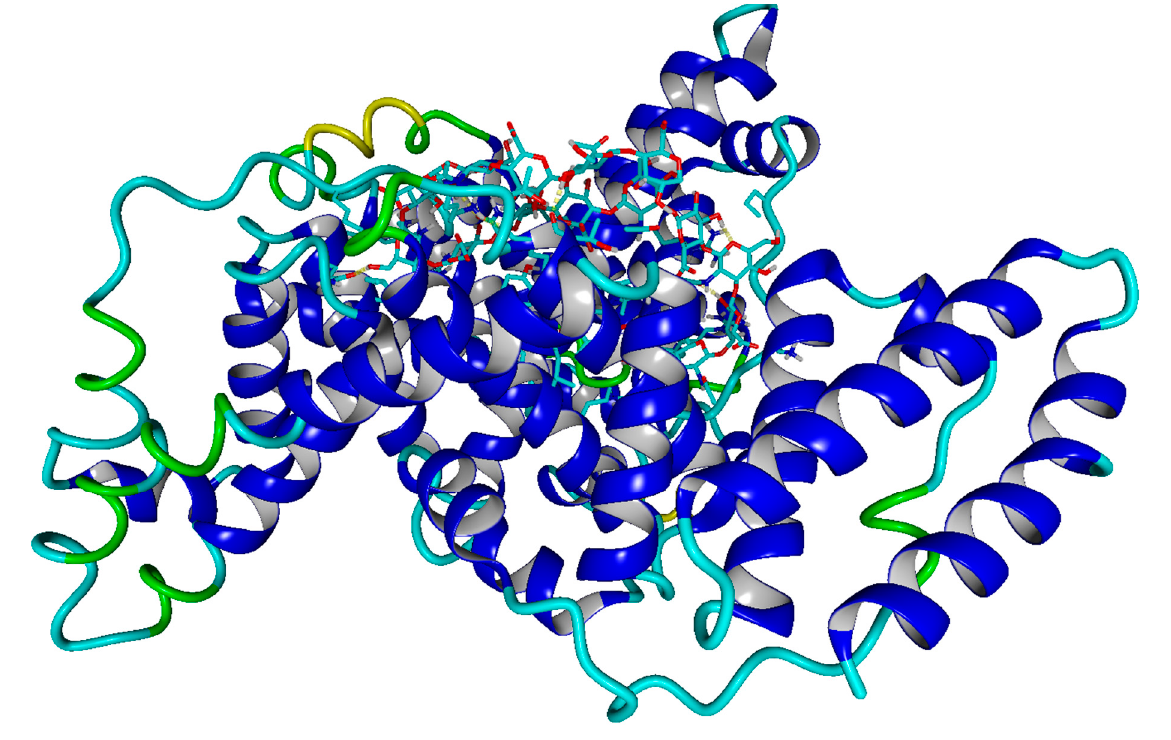
Figure 9. Visualization of BSA–HA complex obtained from docking. BSA is represented in ribbon-like structure, whereas HA is shown as stick model.